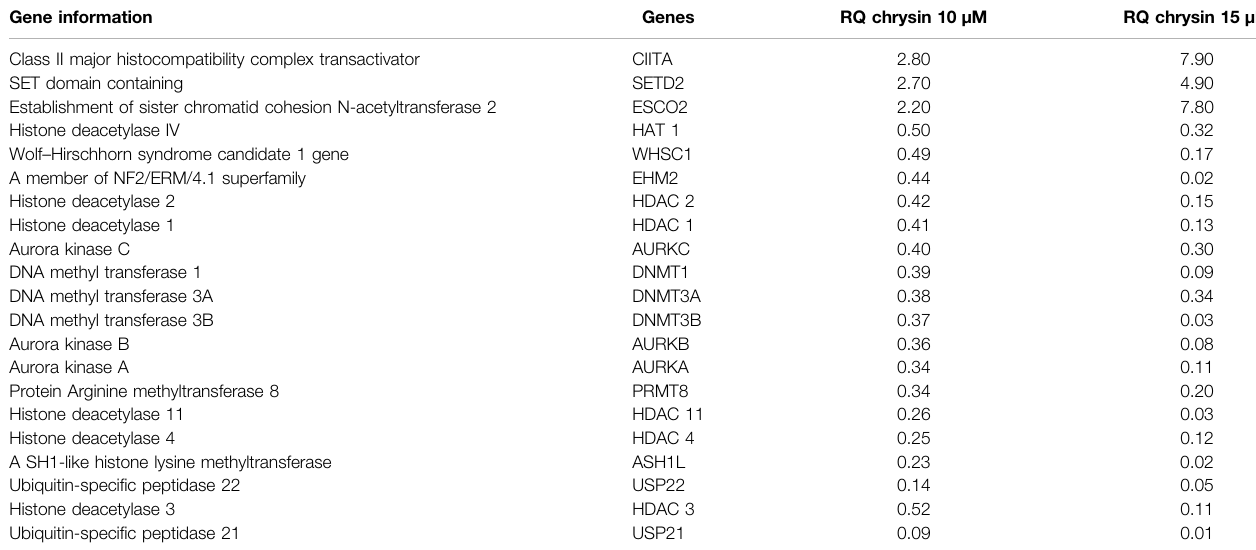
TABLE 3 | RQ values of chromatin-modifying enzymes after chrysin treatment. The values are taken as mean of three experiments ± SD ( p ≤ 0.05). Gene